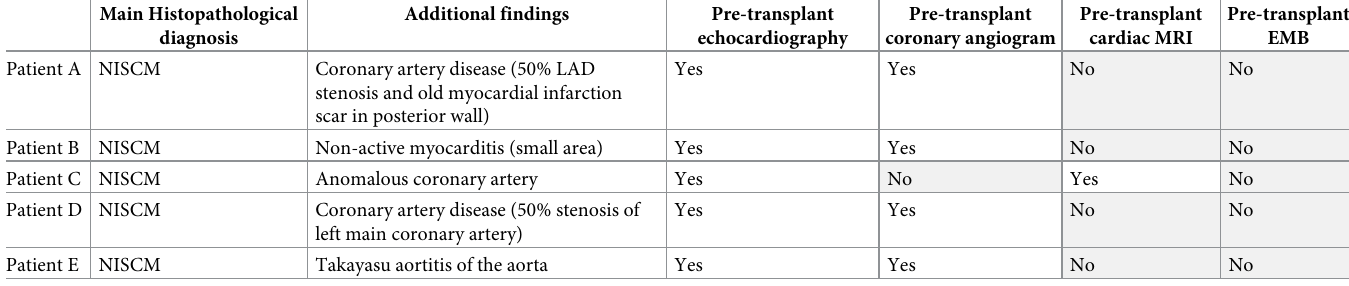
Table 4. Multimodality imaging in 5 patients with additional